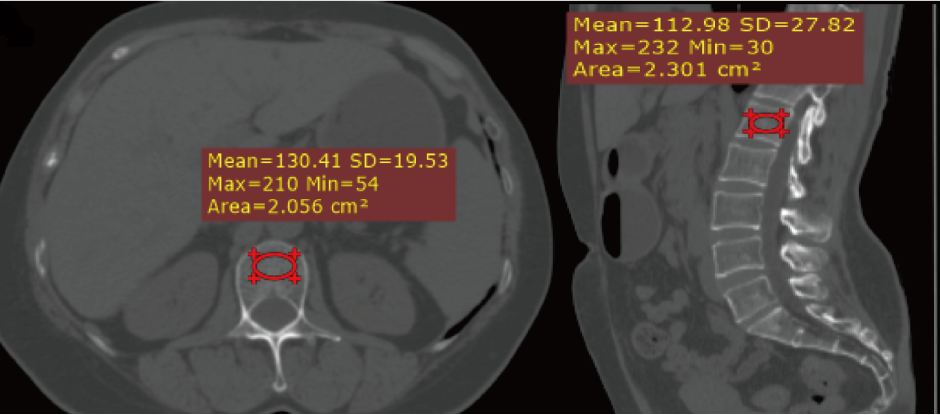
Figure 1. Coronal ( left ) and sagittal ( right ) CT images of lumbar spine (L1) in a 52-year-old women patient with pancreatic neuroendocrine tumors (PNETs).